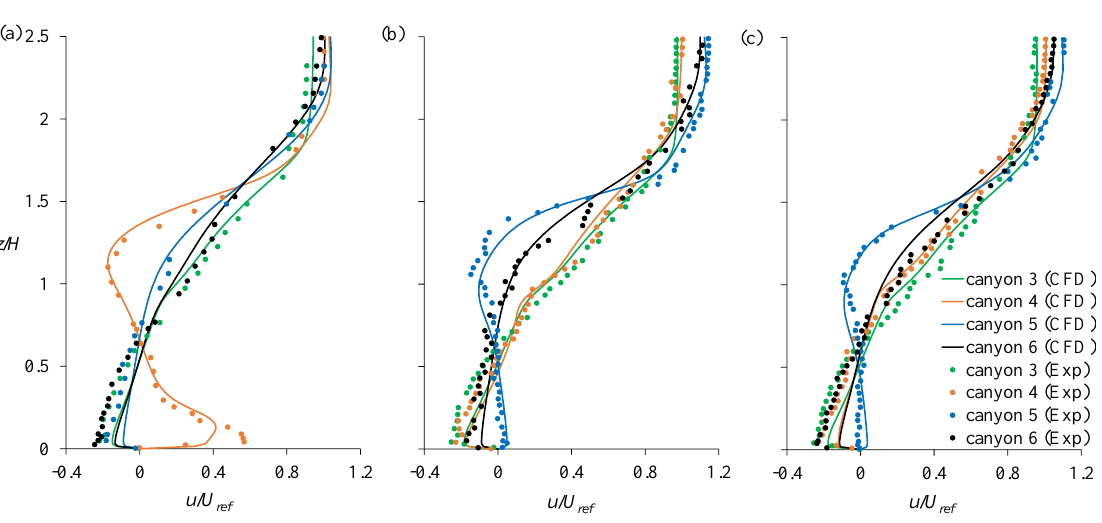
Figure 12. CFD model validation with experiments for the cases of ( a ) wind catcher, ( b ) reversed wind catcher, and ( c ) step-up/step-down canyons.